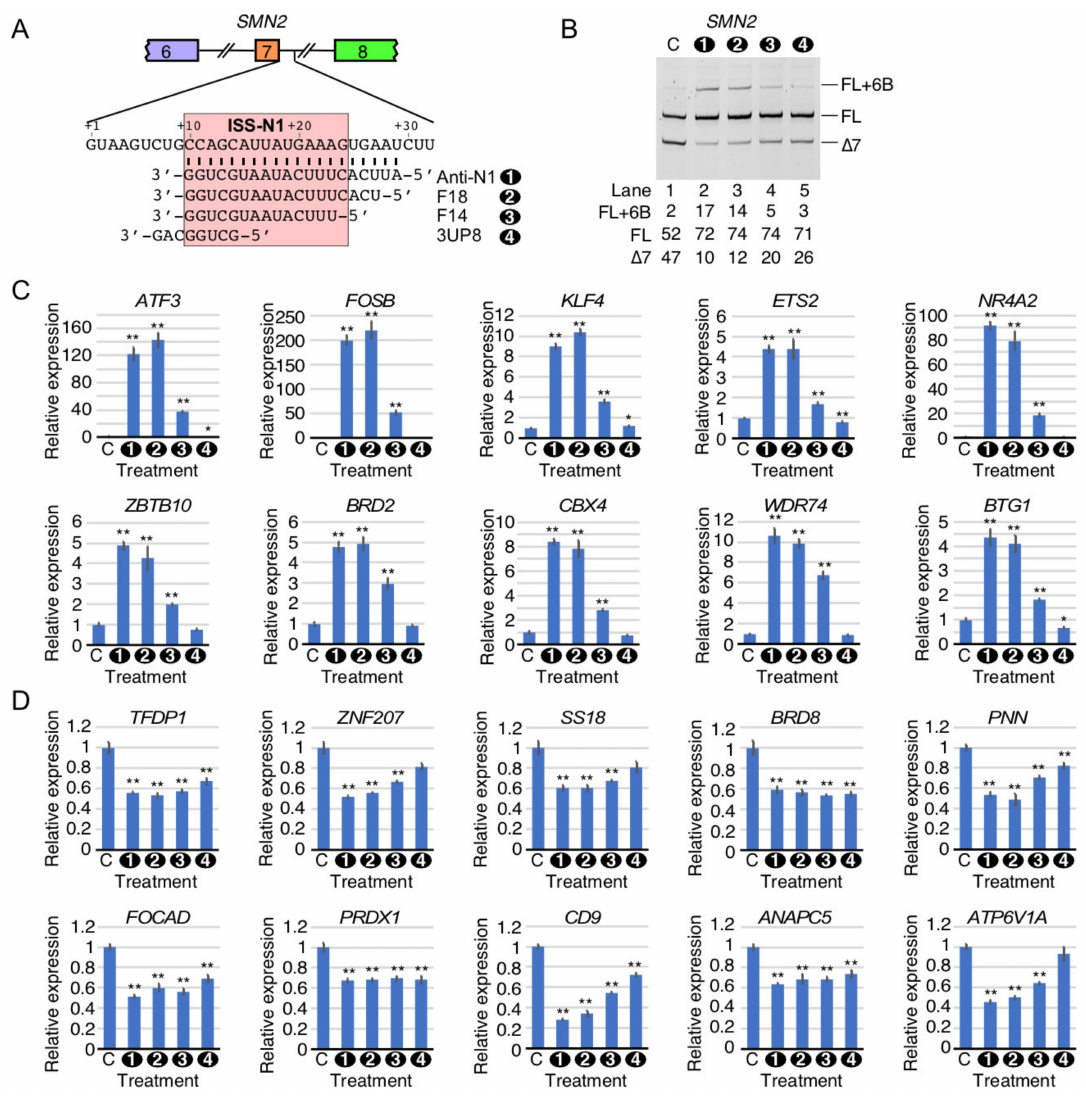
Figure 8. Comparison of perturbed expression of genes by ISS-N1-targeting splice-switching oligonucleotides. ( A ). Se- quences and target binding sites of four Anti-N1 targeting splice switching oligonucleotides (ISOs). Labeling and coloring is the same as Figure 1A. For brevity and clarity, the ISOs are numbered 1–4 as indicated. ( B ). Effects of ISO treatment on SMN2 splicing. Treatments are indicated at the top of the gel, with “C” signifying the treatment with the nontargeting control ASO. Splice isoform identity is indicated at the right side of the gel. The percent of total transcript for each splice isoform is indicated below the gel. ( C ). qPCR validation of the upregulated genes after ISO treatment. Gene symbols are shown at the top of each panel. Y axis: relative expression to non-targeting control. Treatments are indicated at the bottom of each graph, with “C” signifying the treatment with the nontargeting control ASO. Error bars represent the standard error of the mean. n = 3. *: p < 0.05. **: p < 0.01. ( D ). qPCR validation of the downregulated genes after ISO treatment. Labeling is the same as in panel